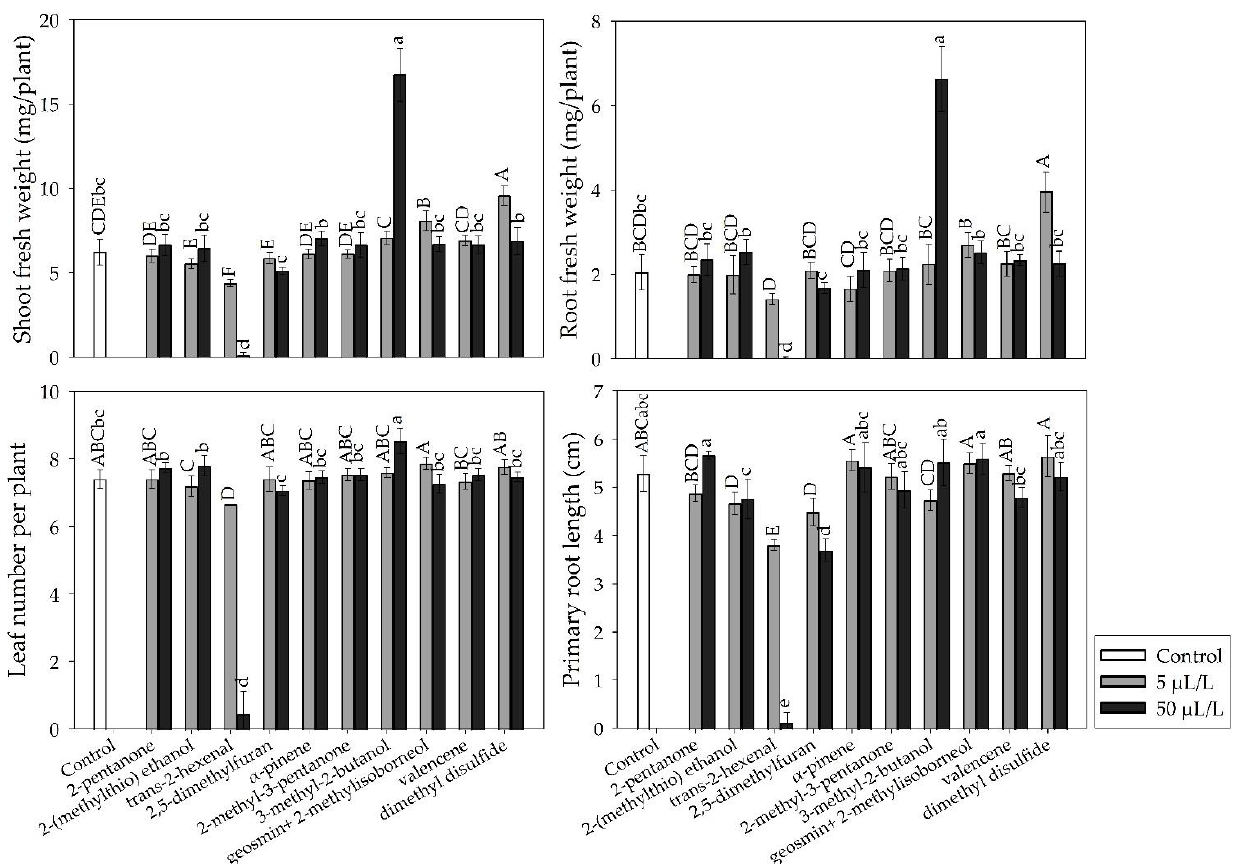
Figure 7. Effects of the exposure to pure VOCs for 10 days (5 and 50 μL /L concentrations) on biomass production in Arabidopsis thaliana . Mean values with the same letters are statistically similar. Thin upper bars indicate the standard deviations of the means.